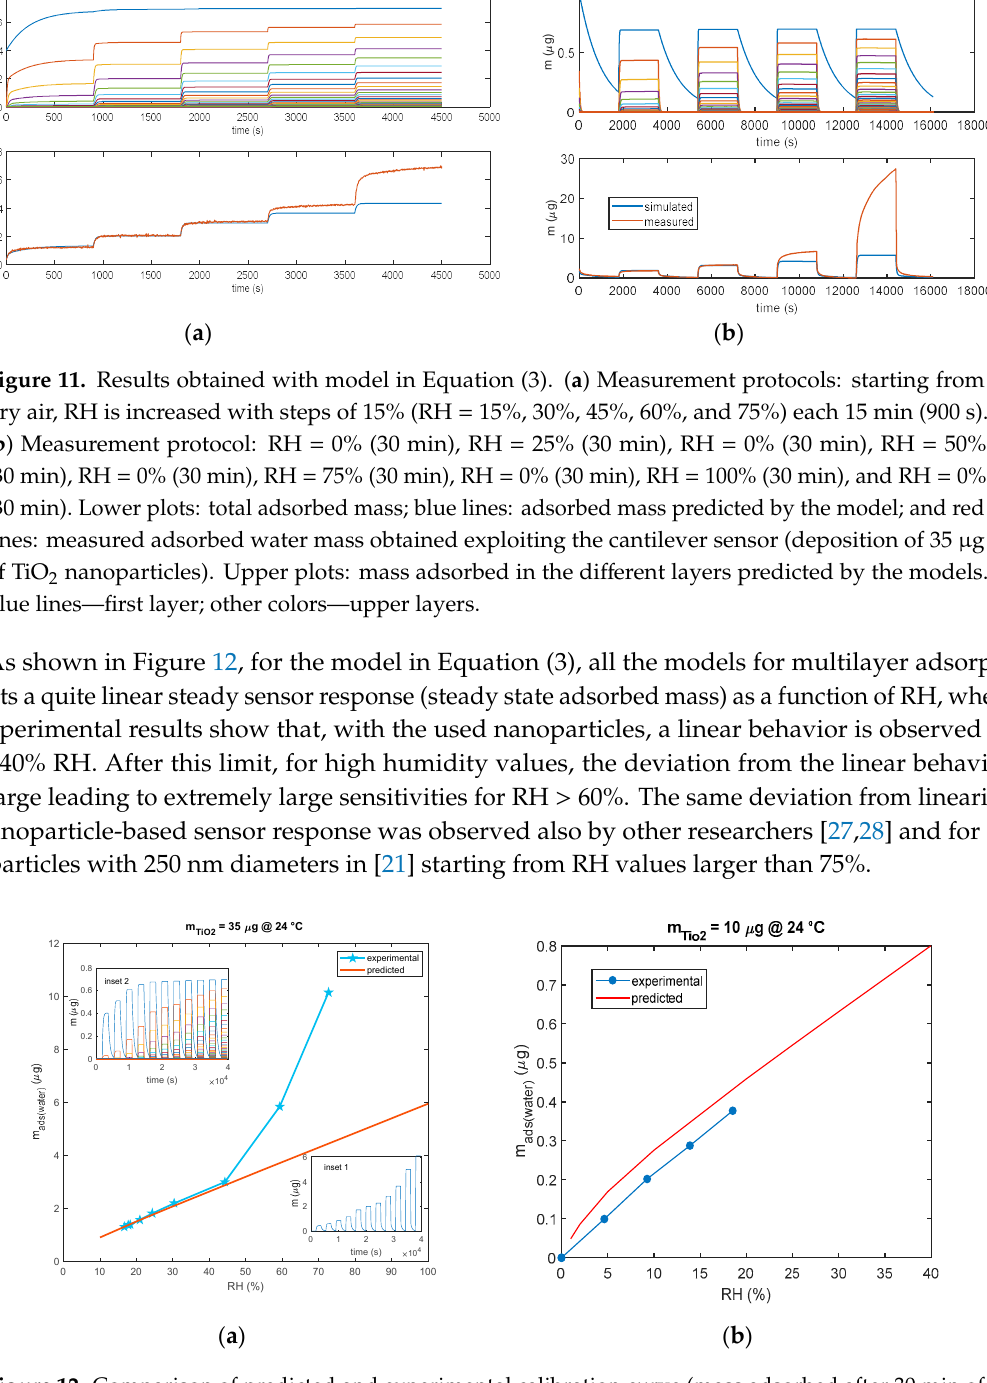
Figure 12. Comparison of predicted and experimental calibration curve (mass adsorbed after 30 min of exposure to each RH level vs. RH). ( a ) The predicted calibration curve (red line) is obtained using the model of Equation (3) and pulses of RH of 30 min duration each and values of 10%, 20%, 25%, 30%, 40%, 55%, 80%, and 100%. Each pulse is followed by a recovery phase with dry air (RH = 0%). Measurements (blue line and marker stars) are obtained with the cantilever sensor and the deposition of 35 µ g of TiO 2 . Insets show the outputs of the model: inset 1—total adsorbed mass and inset 2—adsorbed mass in the individual layers. ( b ) The predicted calibration curve (red line) is obtained using the model of Equation (3) and pulses of RH of 30 min duration each and values of 1%, 2%, 5% 10%, 20%, 25%, 30%, and 40%. Each pulse is followed by a recovery phase with dry air (RH = 0%). Measurements (blue line and marker circles) are obtained with the QCM sensor and 10 µ g of TiO 2